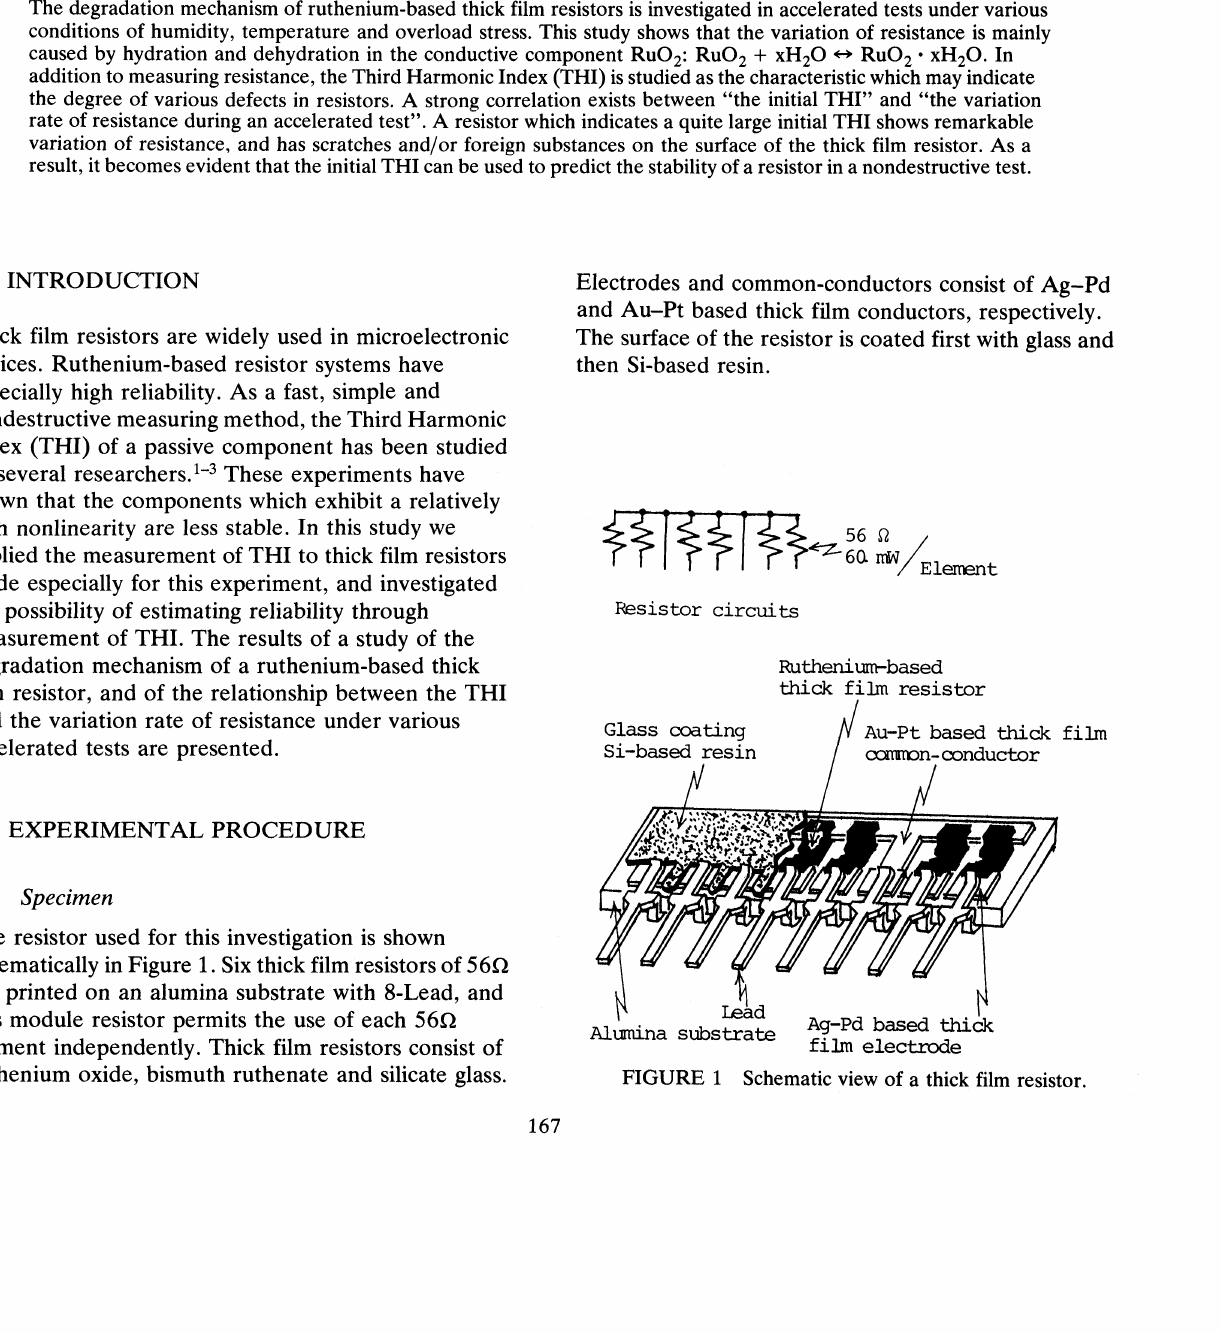
FIGURE Schematic view of a thick film